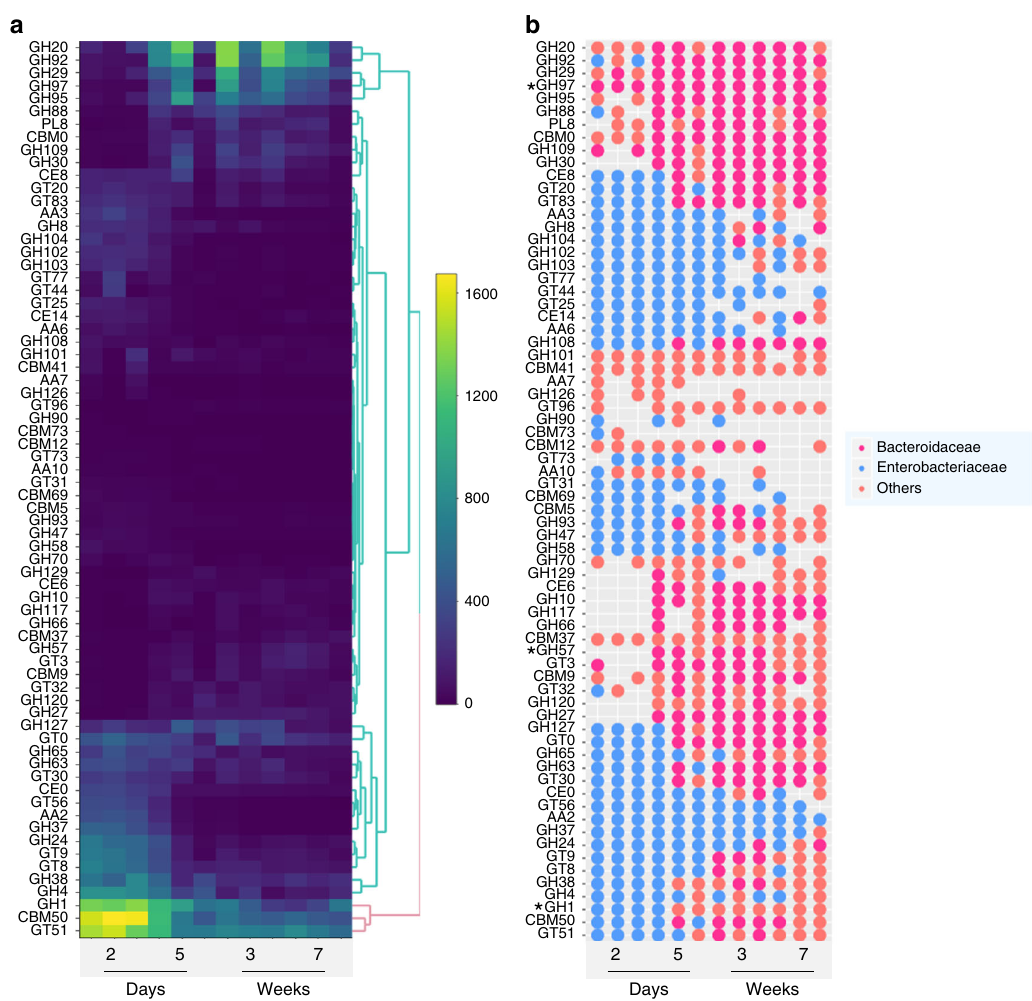
Fig. 10 The abundance, distribution and predicted bacterial taxonomy of fecal CAZy families. a Heatmap depicting the normalized distribution of CAZy enzymes over time, including only differential abundant enzymes ( n = 70). b The most abundant bacterial family predicted to produce the corresponding CAZy enzymes. Dots indicate that the predicted family was either Enterobacteriaceae (blue), Bacteroidaceae (pink), or Others (orange). The absence of a dot indicates that either our inability to predict the bacterial origin or the CAZy family was not detected in a particular calf at a particular time point. Enzymes families GH1 which includes lactase (EC 3.2.1.108), GH97 which includes glucoamylase (EC 3.2.1.3) and α -glucosidase (EC 3.2.1.20)), and family GH57, which includes α -amylase (EC 3.2.1.1) are highlighted with asterisks. Abbreviations: GH, glycoside hydrolases; GT, glycosyltransferases; PL, polysaccharide lyases; CE, carbohydrate esterases; AA, auxiliary activities; CBM, carbohydrate-binding modules. Families CBM0, CE0, and GT0 refer to unclassi fi ed CBMs, CEs and GTs, respectively, in CAZy database download 07152016. Differential abundance analysis with DESeq2 revealed that 71 CAZy families signi fi cantly changed over time in dairy calves, however, we failed to retrieve the bacterial origin of one CAZy family, GT80, and thus there are a total of 70 CAZy families shown here. Source data are provided as a Source Data fi